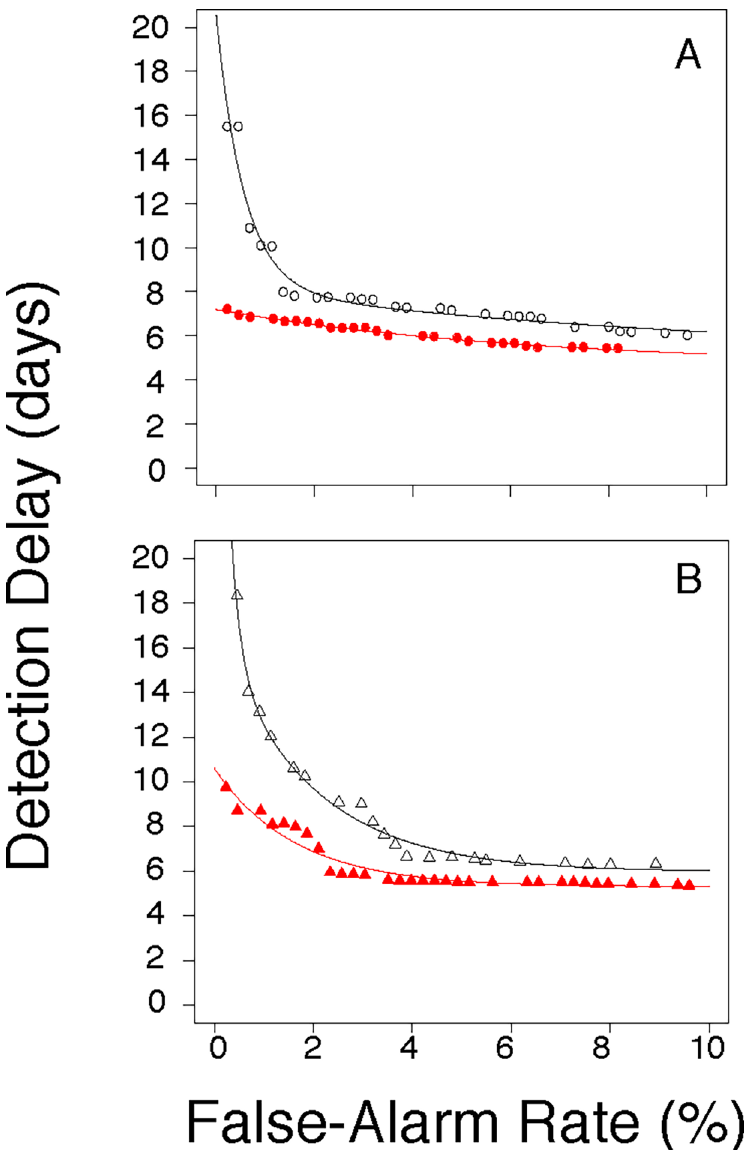
Fig 2. Performance comparisons: Synthetic contexts. Activity monitoring operating characteristic (AMOC) curves showing average detection delay (y-axis) as a function of daily false alarm rate (x-axis) for discovering a synthetic outbreak signal introduced into the s17 (panel A) or s33 (panel B) synthetic background time series of daily case counts. Aberrancy detection was performed using either EARS (open black symbols) or SARIMA (closed red